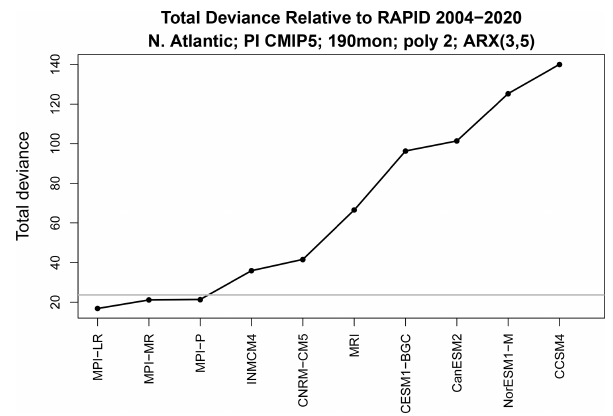
Figure 6. Total deviance between CMIP5 simulations and obser- vational time series of the AMOC. Each time series is 190 months long and modeled by an ARX(3,5) model. The horizontal grey line shows the 5% significance